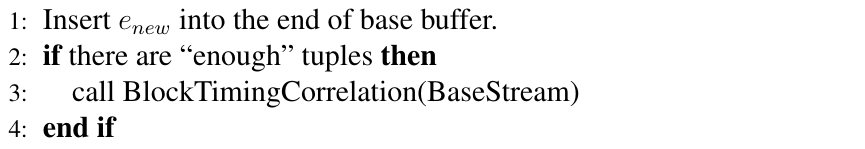
Algorithm 4 LazyTimingCorrelation( e